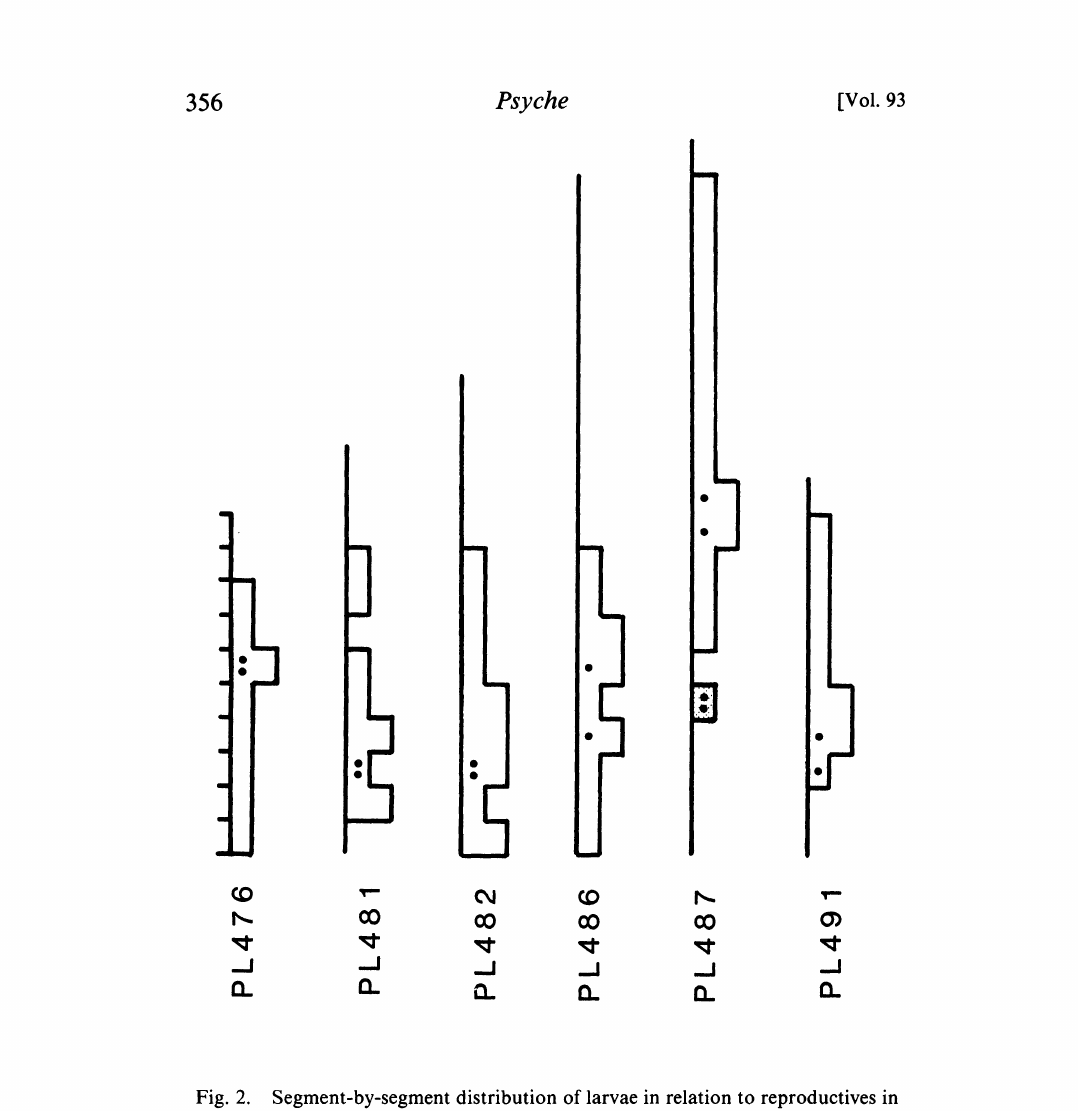
Fig. 2. Segment-by-segment distribution of larvae in relation to reproductives in 6 colonies (colonies PL477, PL480, and PL490 were omitted because they had too few larvae). The size of individual segments analyzed separately is indicated by the tick-marks on PL476. For each colony, the baseline alone indicates uninhabited wood; low boxes indicate fewer larvae, high boxes indicate more larvae than expected for that segment (based on the average number of larvae per segment for that colony). Dots represent reproductives. The shaded segment represents PL488, an incipient colony contained entirely within a single